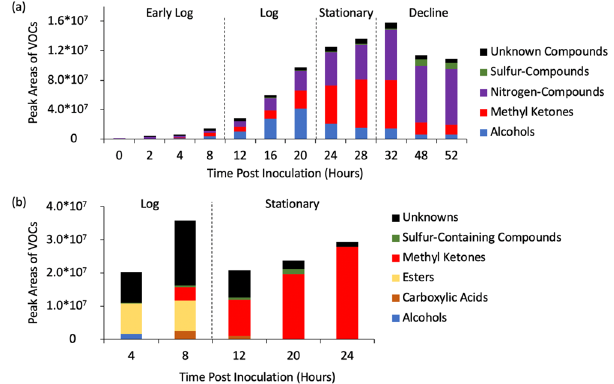
Figure 4. Mean combined peak areas (integrated detector counts) for marker compounds within individual classes at each timepoint post bacterial inoculation of cultures for ( a ) F. tularensis novicida and ( b ) B. anthracis Sterne.